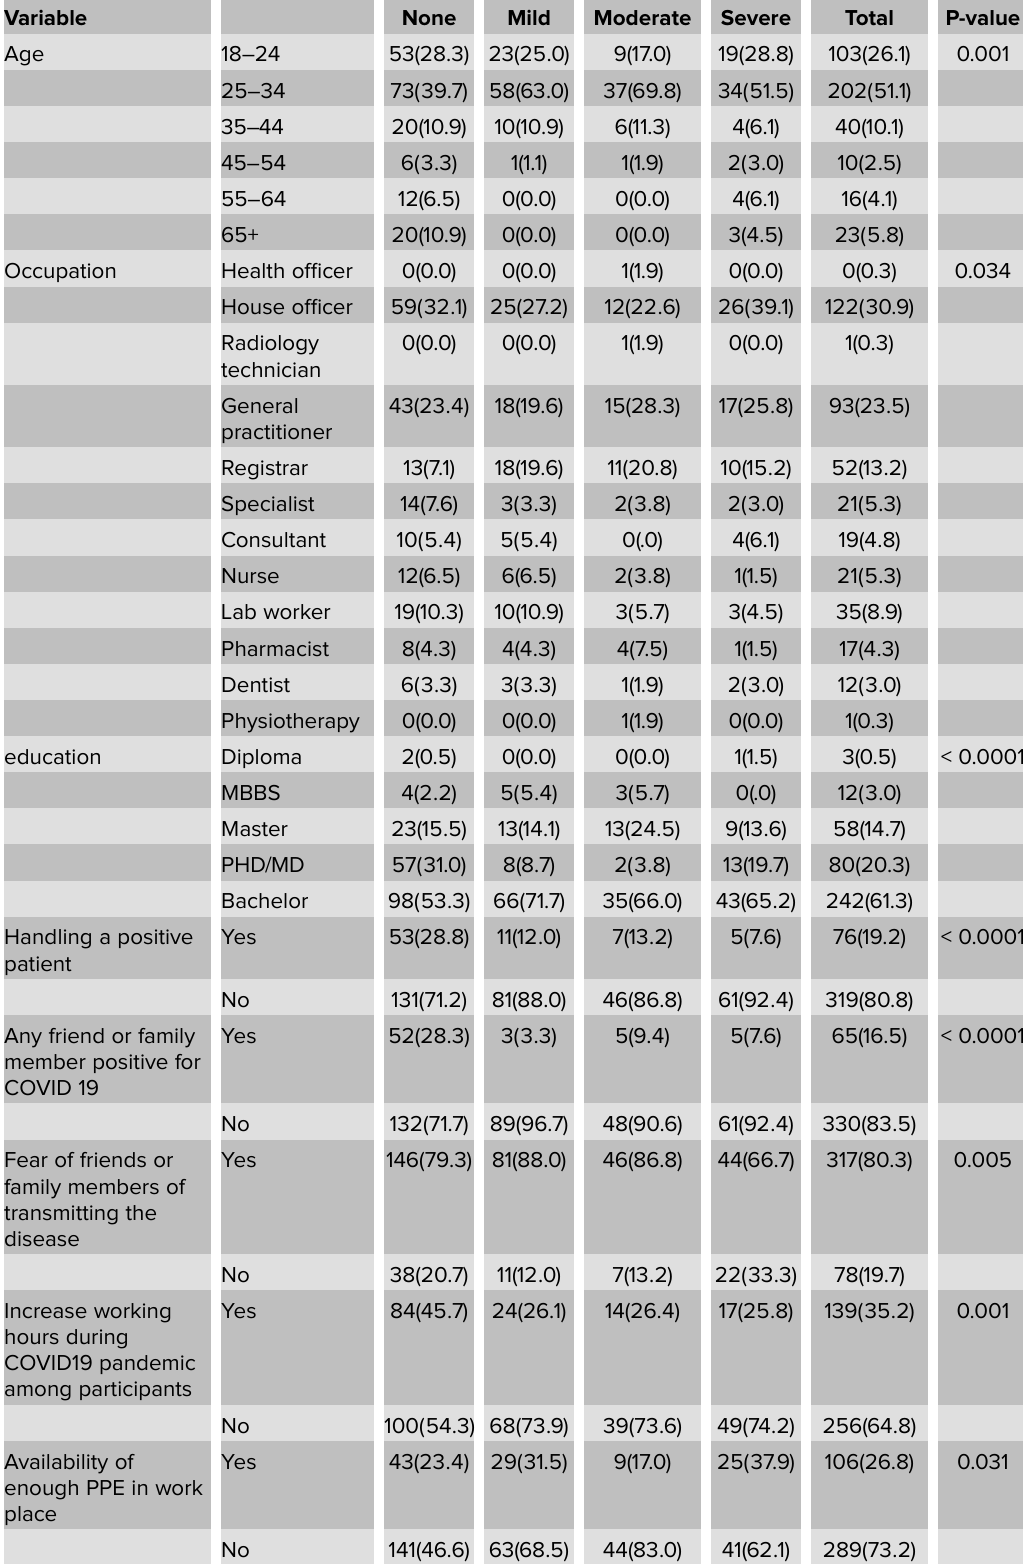
TABLE 7: Comparison of demographic characteristics, COVID-19 exposure, and perception with GAD-7 scale